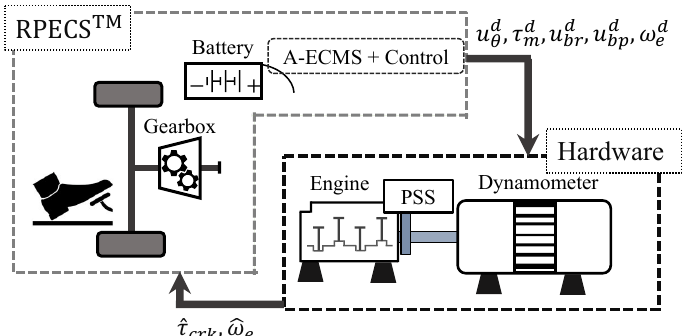
Figure 10. Hardware-in-the-loop (HIL)